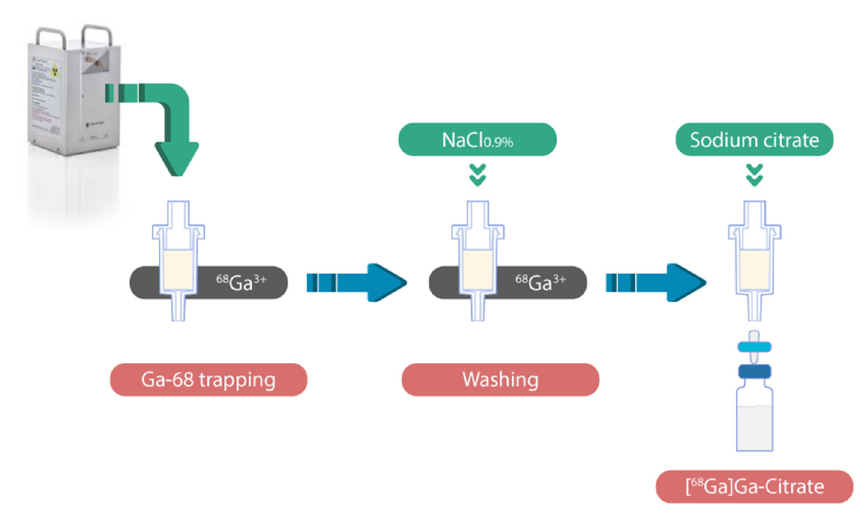
Figure 1. [ 68 Ga]Ga-citrate radiosynthesis strategy.